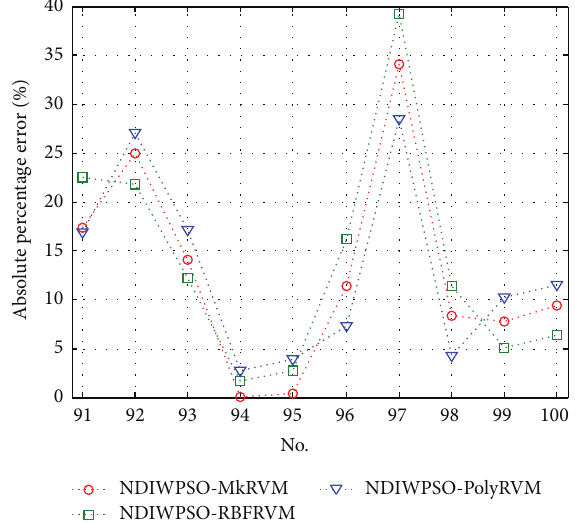
Figure 7: The comparison of the absolute percentage prediction errors for kurtosis of bearing vibration signal among NDIWPSO- MkRVM, NDIWPSO-RBFRVM and NDIWPSO-PolyRVM in case